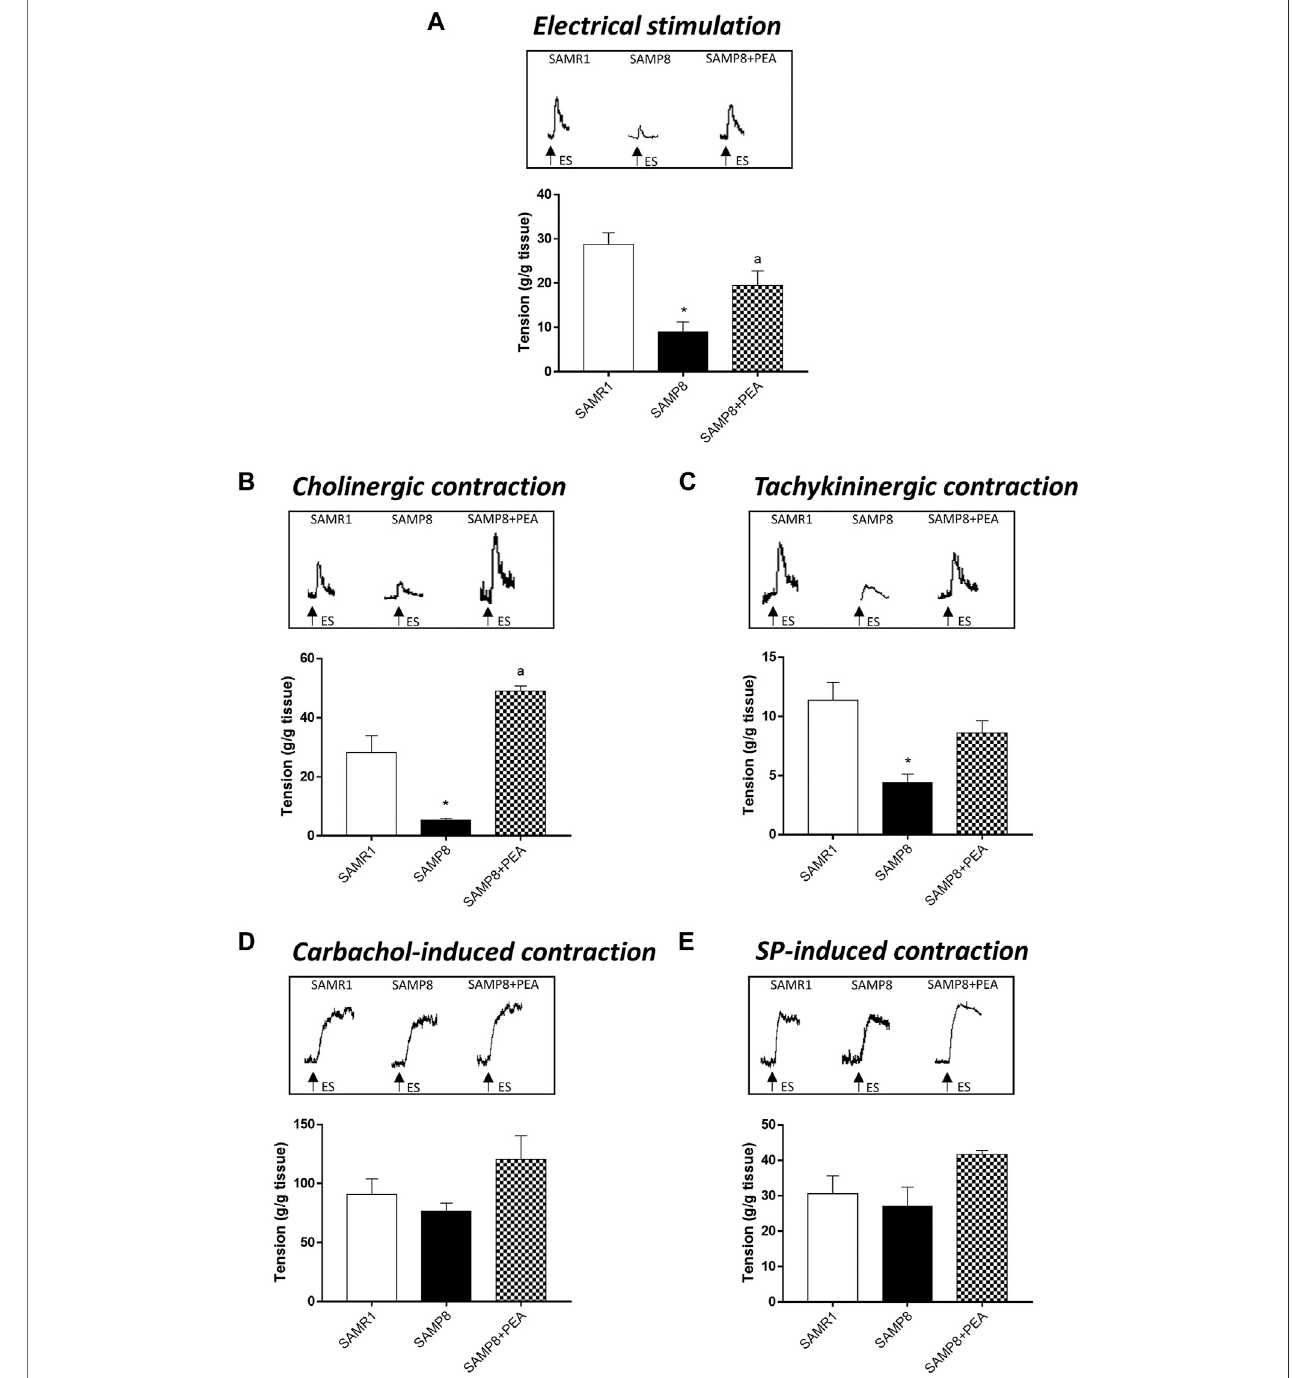
FIGURE2| PEAimprovesthebowelmotordysfunctionsassociatedwithAD.EffectofPEAon invitro coloniccontractileresponses. (A) ES(10 Hz), (B) cholinergic contractionsand (C) NK 1 -mediatedtachykininergiccontractionsoncontractileactivityofcoloniclongitudinalsmoothmusclepreparationsisolatedfromSAMR1,SAMP8 and SAMP8 treated with PEA. Contractions evoked by (D) carbachol (10 µM) or (E) exogenous SP (1 µM) in colonic preparations isolated from SAMR1, SAMP8 and SAMP8 treated with PEA. (A – E) Tracings in the inset on the top of panels display the contractile responses. Each column represents the mean ± S.E.M. from four animals. One-way ANOVA followed by Tukey post hoc test results: * p < 0.05, signi fi cant difference vs. SAMR1 and a p < 0.05, signi fi cant difference vs. SAMP8; Abbreviations : ES, electrical stimulation; PEA, palmitoylethanolamide; SP, substance P.